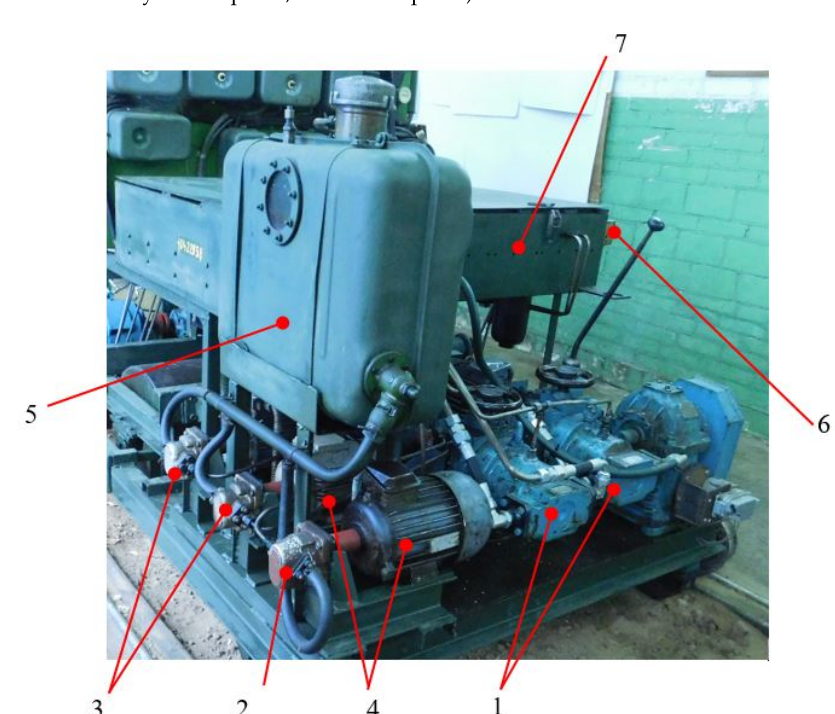
Figure 10. A pump station (1—adjustable pump NAR-40/200; 2—gear pump NCH-6; 3—gear pump NCH-10; 4—electric motor; 5—tank; 6—flow regulator; 7—station hydraulic panel).